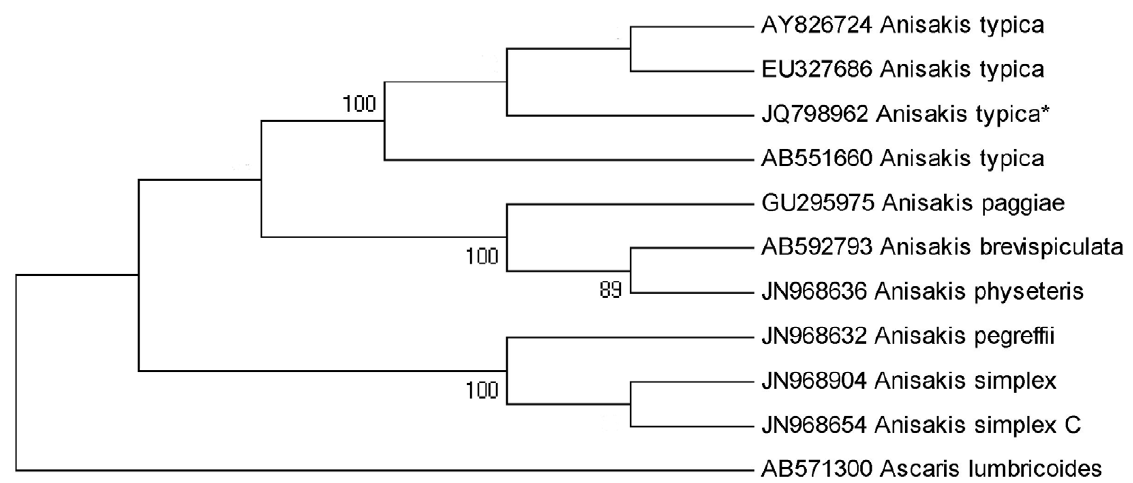
Figure 3. Maximum likelihood reconstruction between sequences of Anisakistypica obtained in this study (*) and sequences of Anisakis species from the GenBank, with the tree inferred from the ITS data set. The numbers on the tree branches represent the percentage of bootstrap resampling. Ascaris lumbricoides was used as an out group.